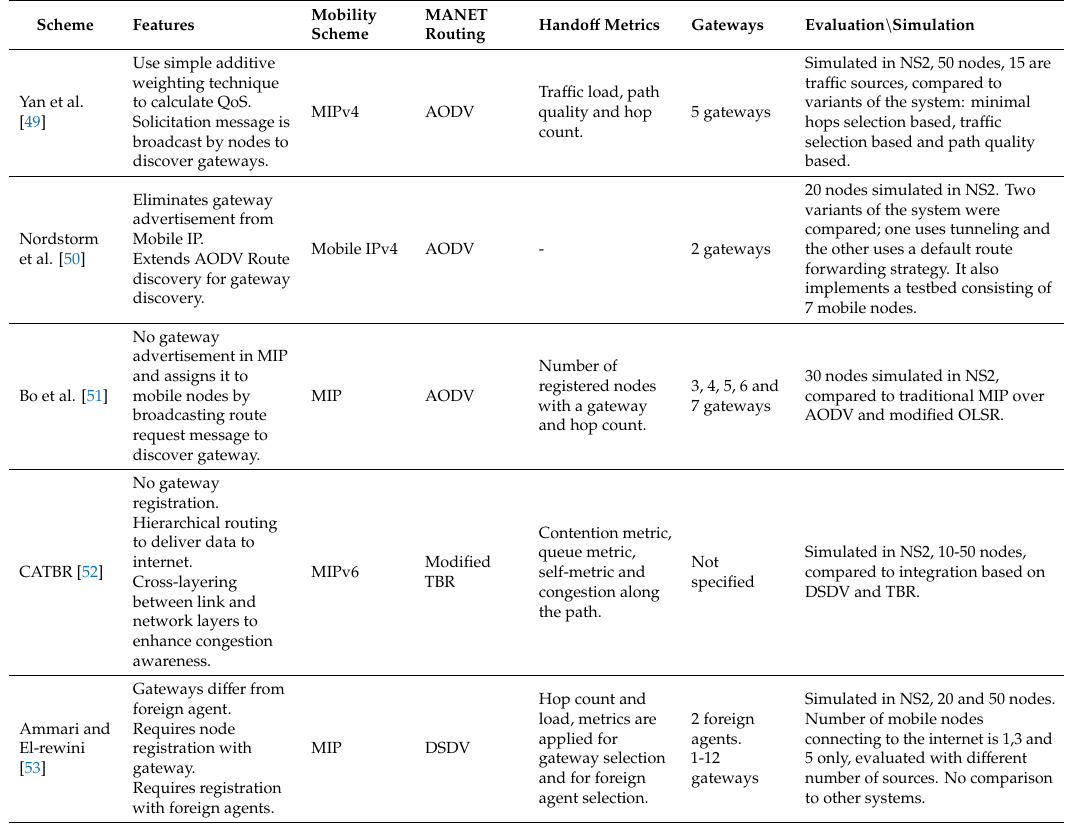
Table 2. Reactive gateway discovery-based mobility management